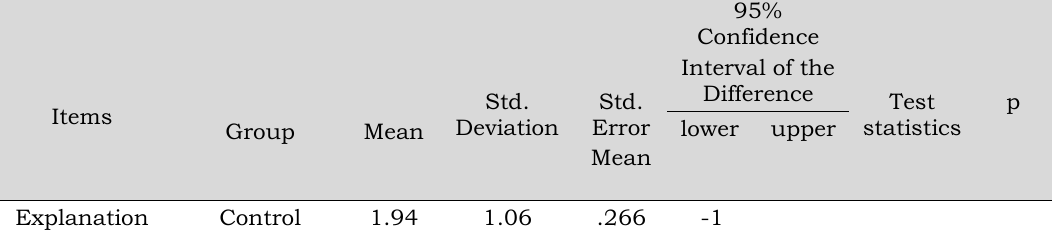
Table 3. Independent Samples Test for Argumentative Essays of Control and Experimental